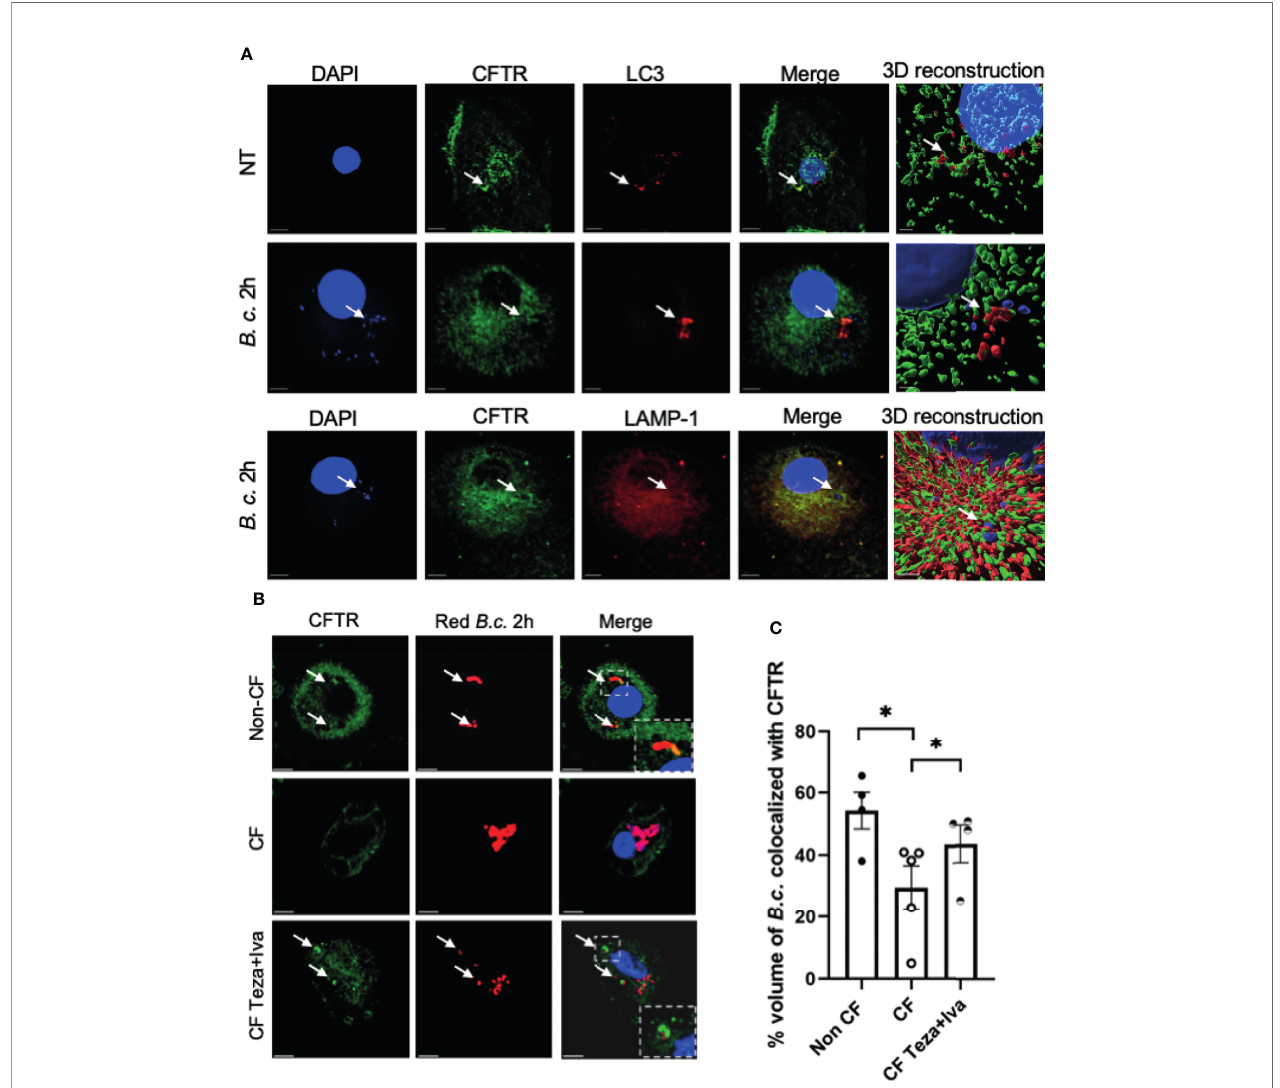
FIGURE 1 | CFTR localizes to LC3-labeled autophagosomes and Burkholderia cenocepacia -containing autophagosomes and autophago-lysosomes. (A) Representative projection and 3D reconstruction from z-stack confocal microscopy images of human non-cystic fi brosis (non-CF) macrophages, either non-infected (NT) or infected with B. cenocepacia (MH1K) for 2 h ( B. c. 2 h ). Macrophages were fi xed and stained for CFTR (Alexa Fluor-488), LC3, and LAMP-1 (Alexa Fluor-594); DAPI was used to stain B. c. DNA. White arrows point to CFTR colocalized with LC3, B. c. , or LAMP-1 (n = 3 biological replicates). Scale bar = 5 µm. (B) Representative confocal microscopy images of human non-CF, CF NT, and CF treated with Teza+Iva for 24 h macrophages. Macrophages were infected with B. cenocepacia expressing RFP for 2 h (red B. c . 2h) and stained for CFTR. White arrows point to CFTR colocalized with red B. c. (C) % volume of red B. c. colocalized with CFTR measured from images in panel (B) Data